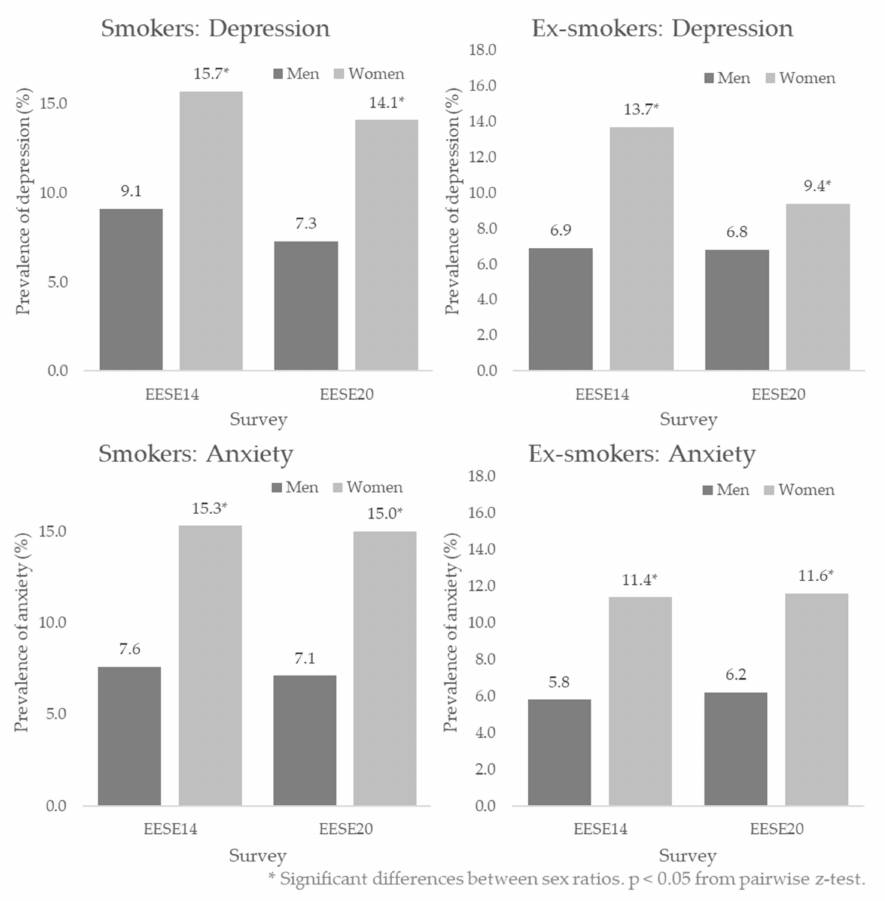
Figure 3. Prevalence of depression and anxiety in Spanish smokers and ex-smokers, and comparison by sex: EESE2014 and